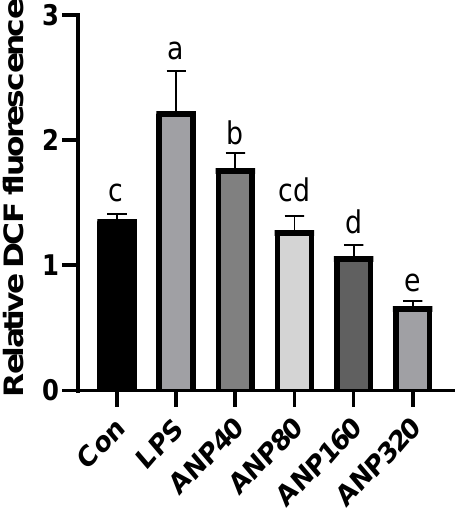
Figure 1. Inhibitory effect of ANP on the intracellular ROS generation. The results shown are expressed as means ± SD ( n = 3). The different letters in the graph indicated significance ( p < 0.05). To confirm the cellular ROS levels after the addition of DCFH, we used fluorescence